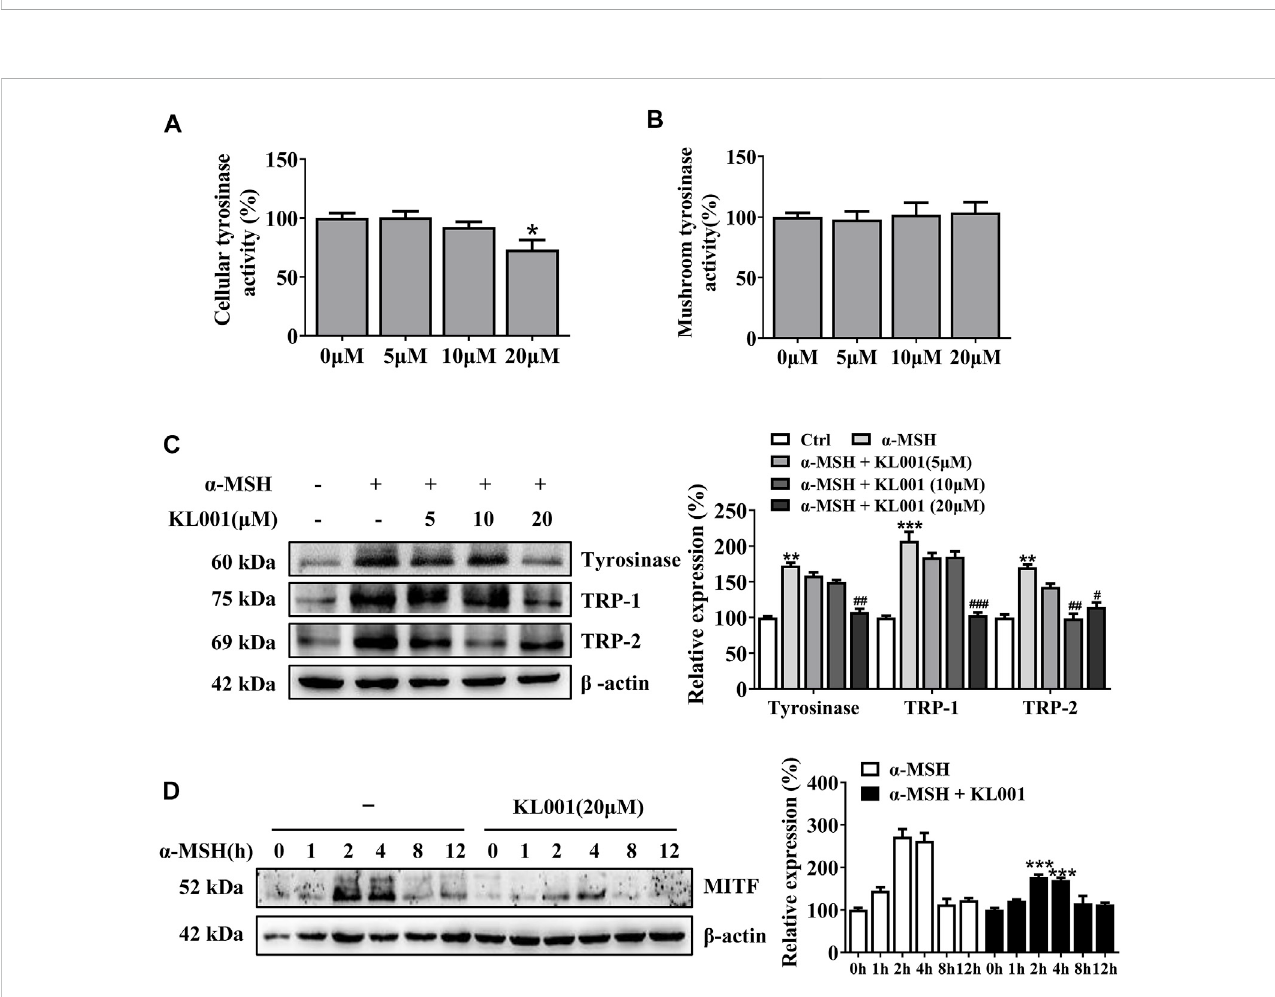
FIGURE 3 KL001 inhibited tyrosinase activity and expression of melanogenic proteins in B16F10 cells. (A) Cellular tyrosinase activity and (B) Mushroom tyrosinase activity were determined as described in methods. (C) Protein expression levels of tyrosinase, TRP-1 and TRP-2 were measured by western blotting after treatment with KL001 for 48 h. (D) MITF protein expressionwas analyzed after treatment with α -MSH in thepresence or absenceof KL001 for different times. Data are expressed as the mean ± SD ( n = 3). * p < 0.05, ** p < 0.01, *** p < 0.001 versus non-treated cells. # p < 0.05, ## p < 0.01, ### p < 0.001 versus α - MSH-treated